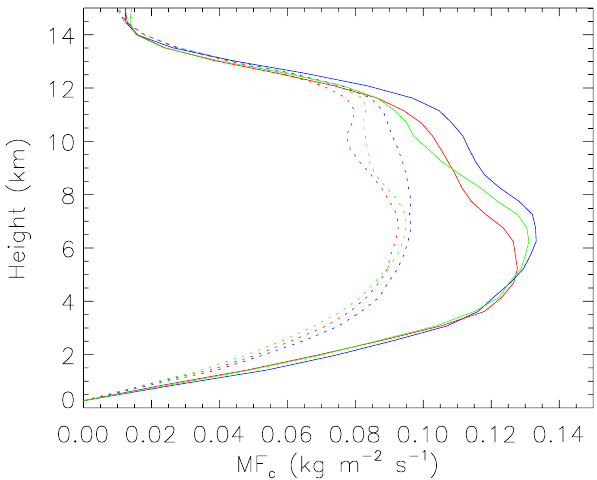
Fig. 4. Vertical profiles of the horizontally-averaged convective mass flux, MF c , for the baseline model configuration (BASE) at t = 90 (dotted) and 120min (solid). Results for pristine, moderately polluted, and highly polluted conditions are shown by blue, green, and red lines, respectively.